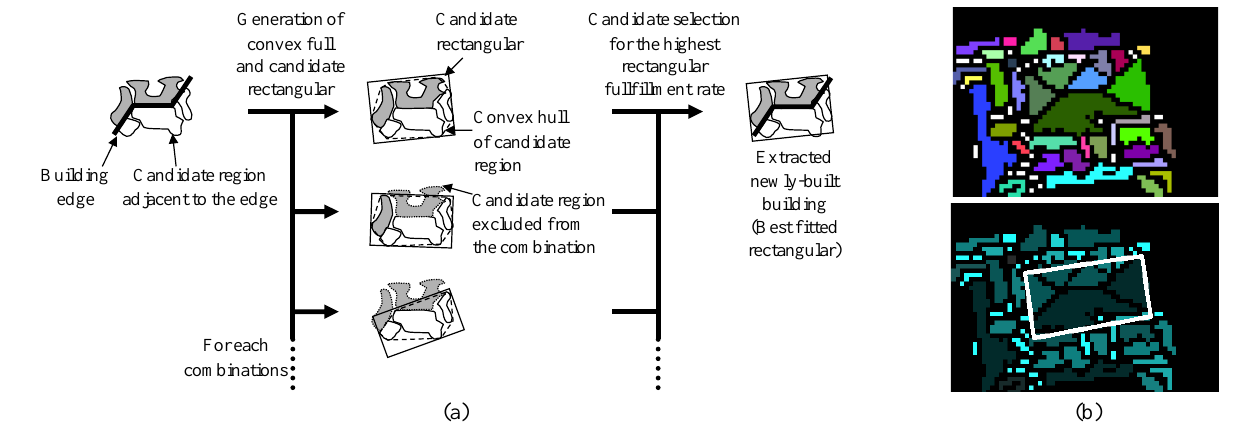
Figure 8. Rectangular fitting.